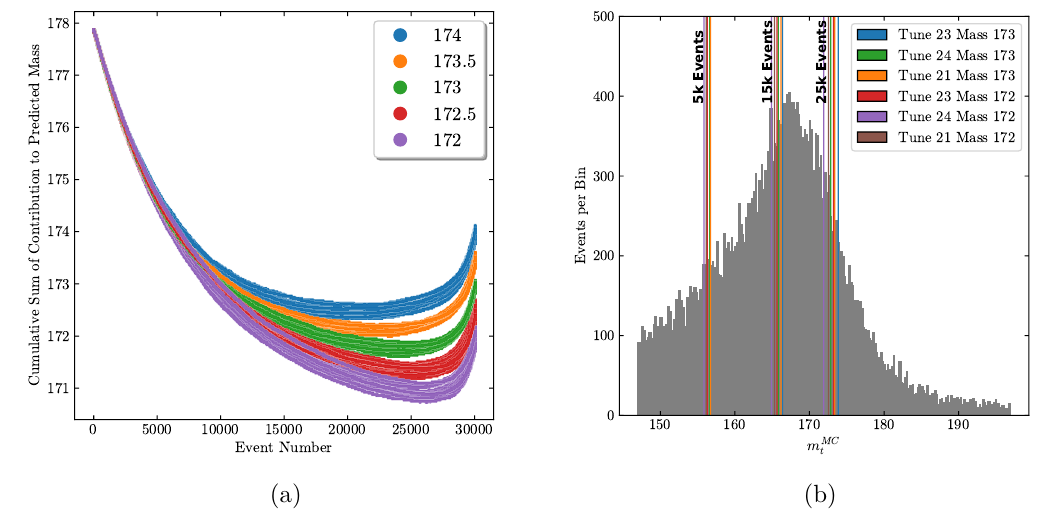
Figure 8. (a): graphical representation of the contribution to the predicted mass as a function of entry number in the sorted ensemble using the network that depends only on the average of the ensemble. The zeroth entry includes the bias. Each point is the cumulative sum up to that entry of the (normalized) input values multiplied by the network weight and divided by the total number of samples. Color denotes the mass. There are fourteen different lines for each color; one example for each tune. (b): histogram showing an example distribution. The solid lines drawn show 5k, 15k, and 25k events for several masses and VAR1